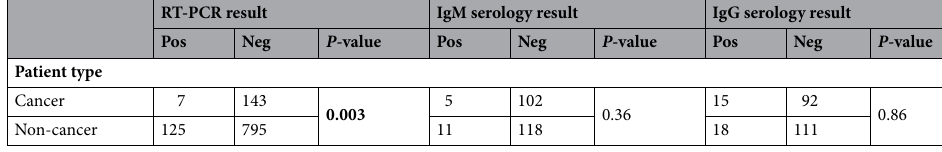
Table 5. Statistical comparison of molecular and anti-body test results in cancer and non-cancer patients. Significant values are in